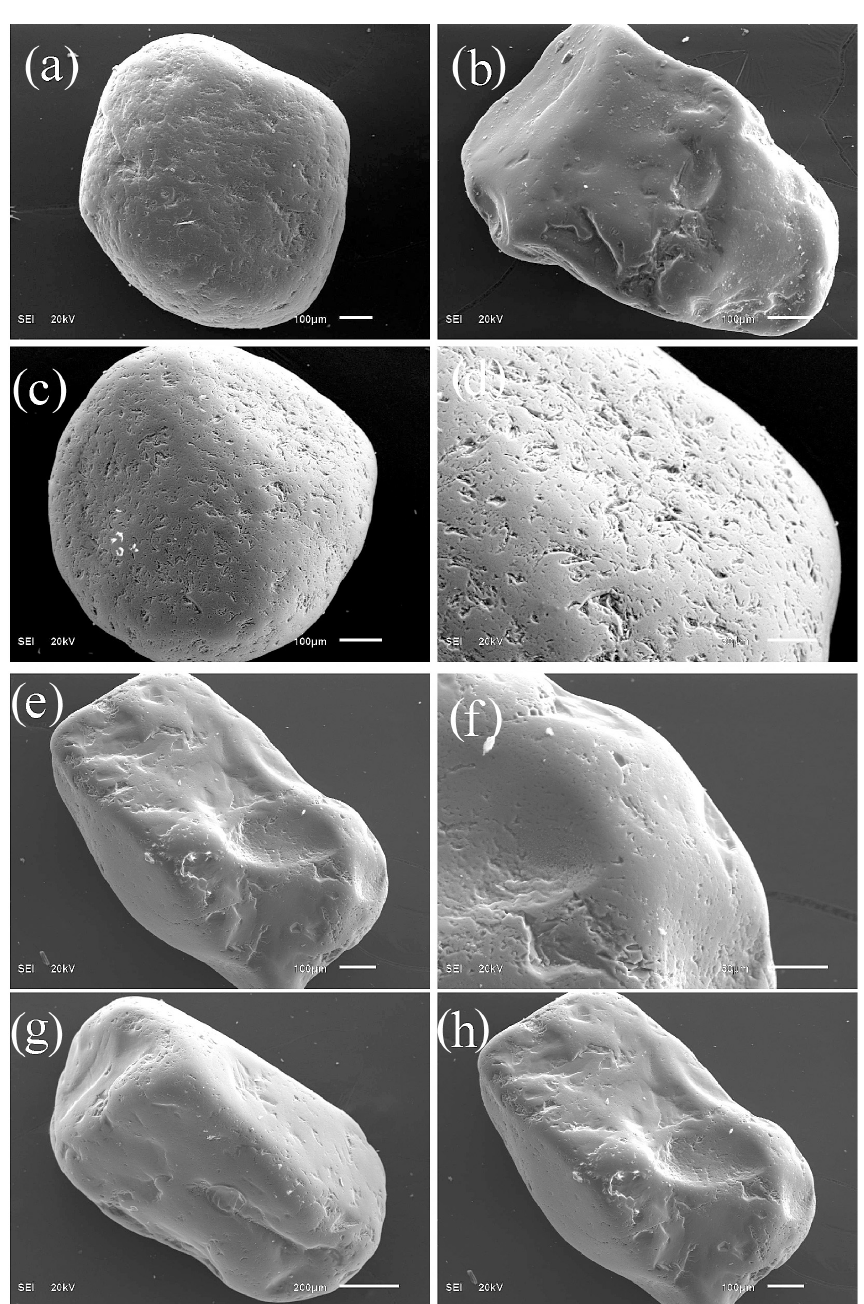
Figure A8. SEM photos of quartz grains from the section NS-13/14: (a) glossy grain with fine-pitted and crescent and V depressions; (b) glossy grain of irregular shape with chips and separate V-shaped recesses; (c, d) half-matte grain with a crescentic texture and micro-pits; (e, f) glossy grain with chips, V shapes, and micro-pits on the protruding parts of the grain; (g) half-matte grain of irregular shape with a fine-pitted texture in the protruding parts of the grain; (h) glossy grain with a conchoidal fracture, V shapes and fine pits on the protruding parts of the